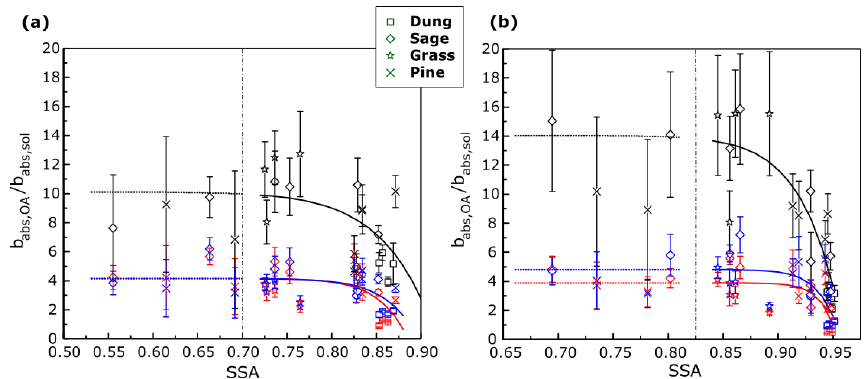
Figure 2. Variation in b abs , OA /b abs , sol with changing SSA at (a) 375nm and (b) 405nm (sample size N = 21). The error bars represent 1 standard deviation from the mean and were calculated using Monte Carlo simulations. The black markers represent water extracts, red markers represent acetone extracts, and blue markers represent methanol extracts. The perforated lines separate points at lower SSA, which have errors greater than 30% due to uncertainties in BC AÅE, from the data at high